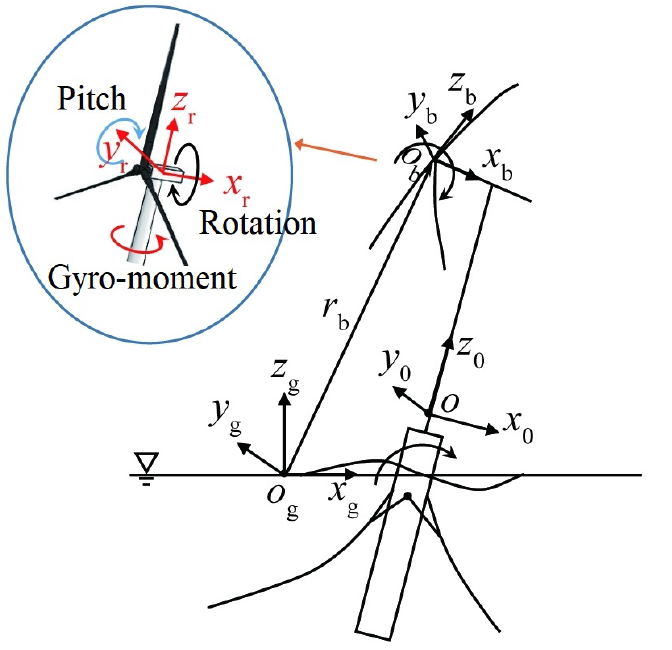
Figure 12. Gyroscopic effect on a FOWT